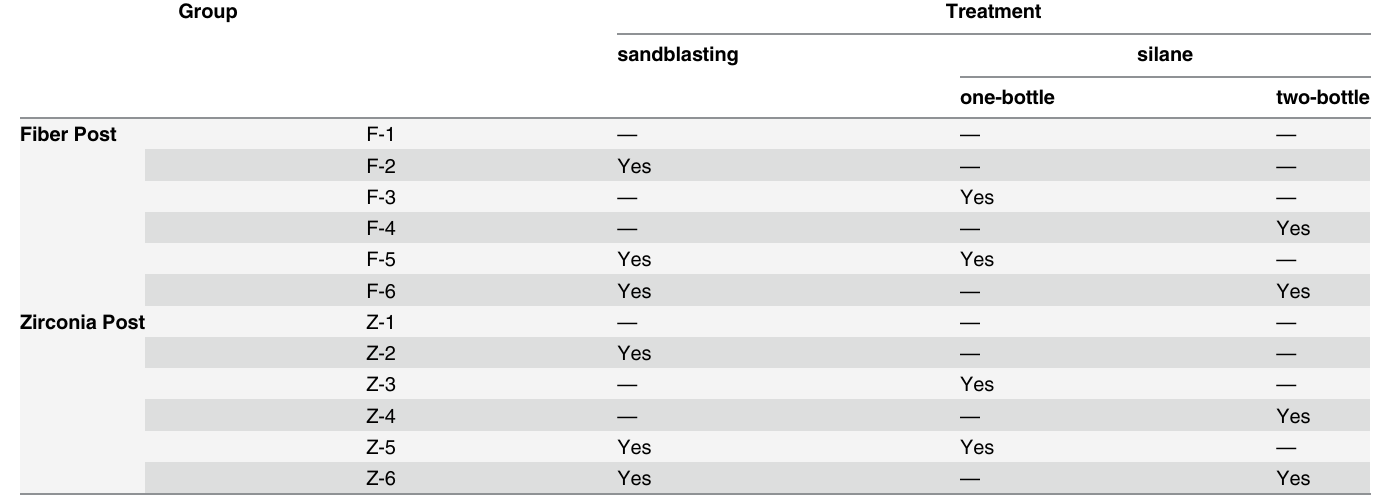
Table 2. The surface treatment condition of the fiber and the zirconia posts.